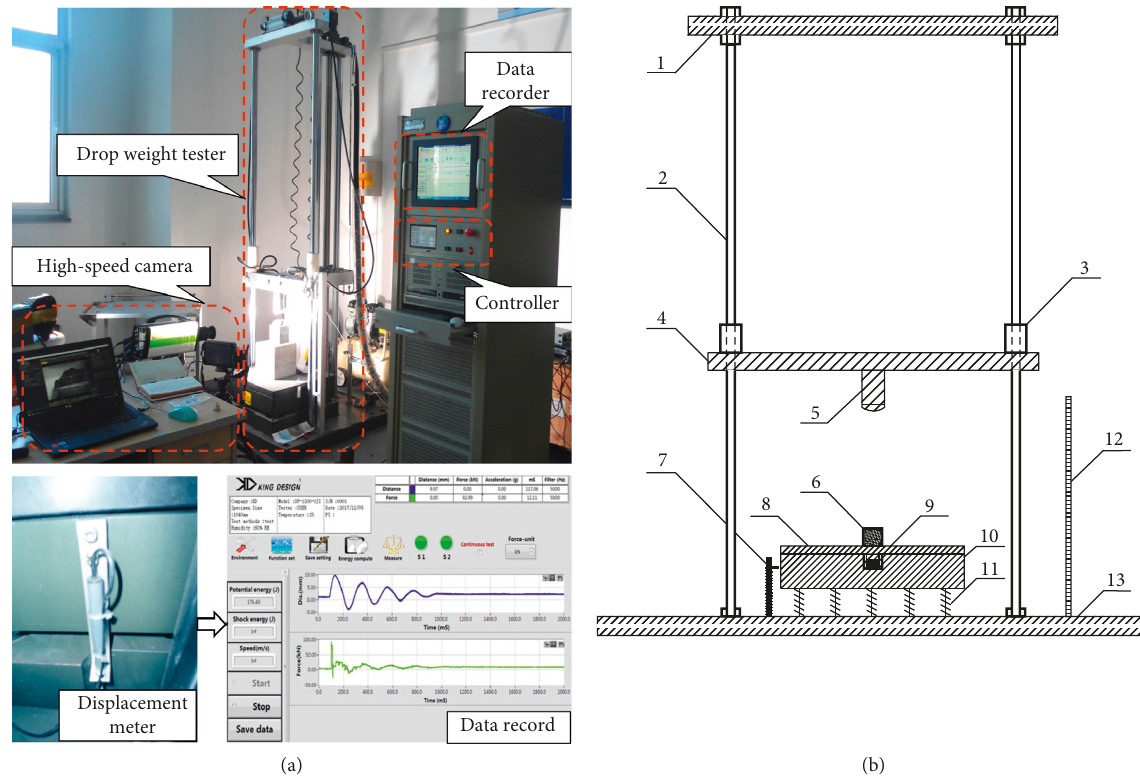
Figure 4: Experimental setup. (a) Experimental apparatus, including drop weight tester with controller and data recorder, high-speed camera, and a laptop. (b) Structure of drop weight tester:1, crossbeam; 2, guide rod; 3, brake; 4, hammer beam; 5, hammerhead; 6, sample; 7, displacement meter; 8, baseplate; 9, force sensor; 10, base; 11, industrial spring; 12, ruler; 13,